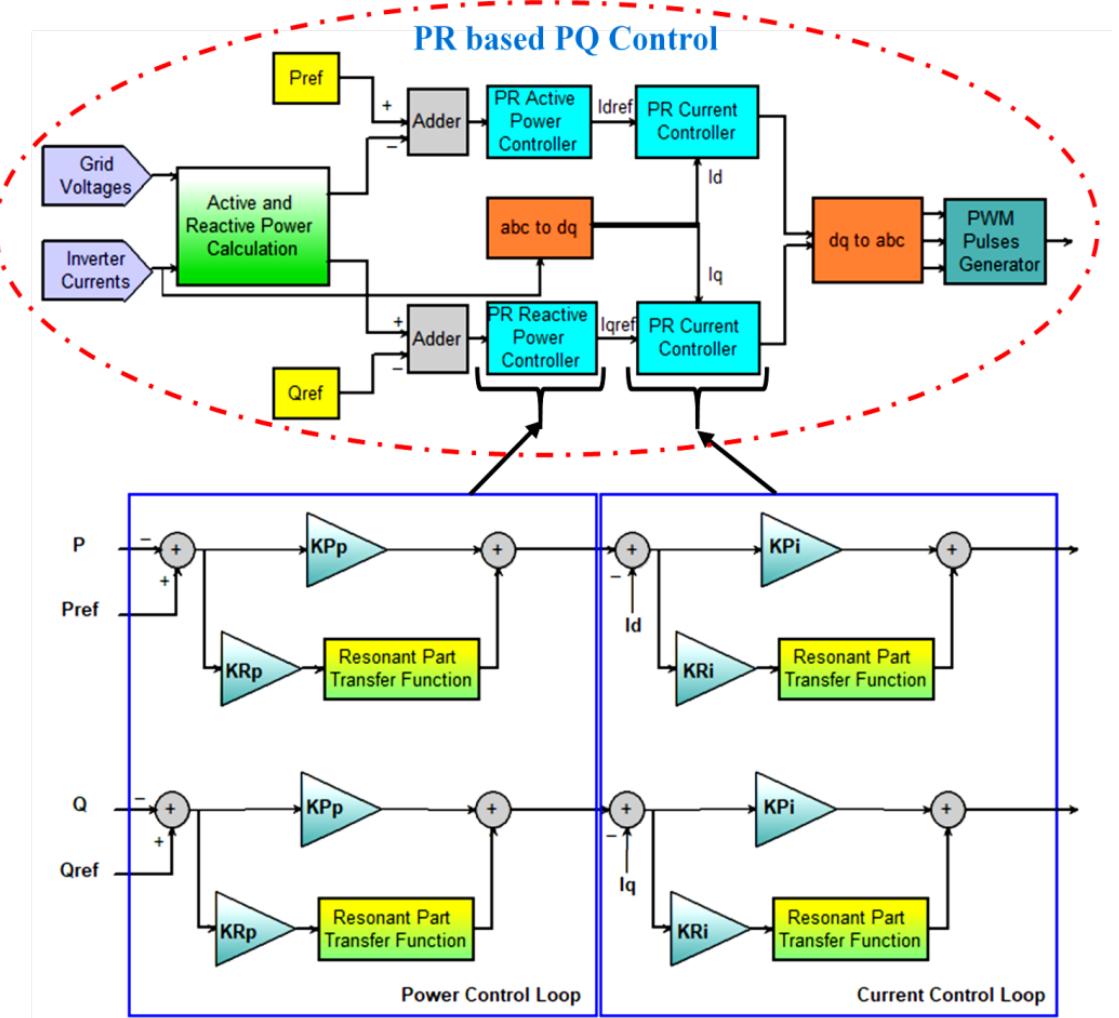
Figure 6. The proposed control technique of one inverter.